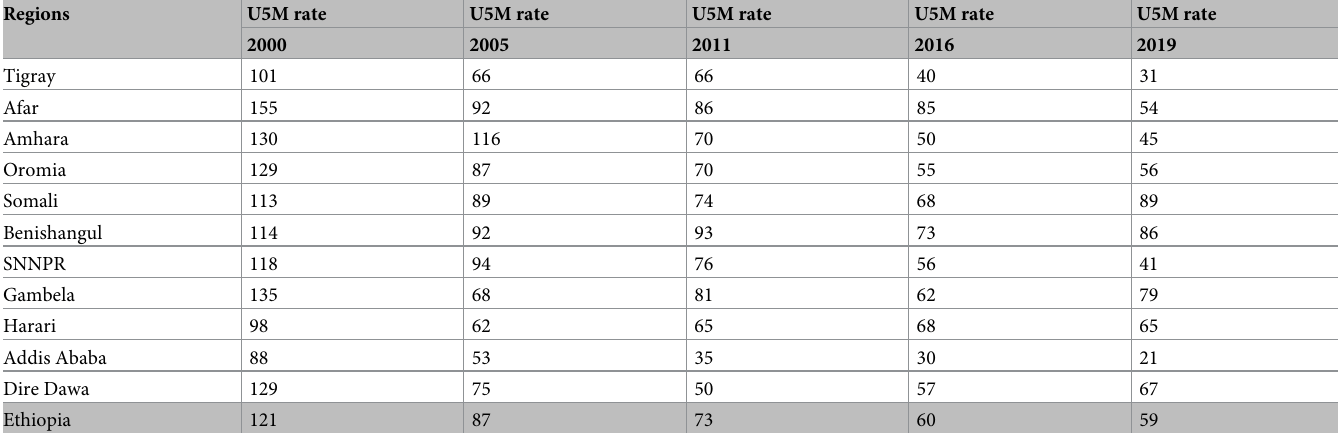
Table 2. National and regional under-five mortality rate per 1000 live births in Ethiopia (2000, 2005, 2011, 2016, and 2019). Regions